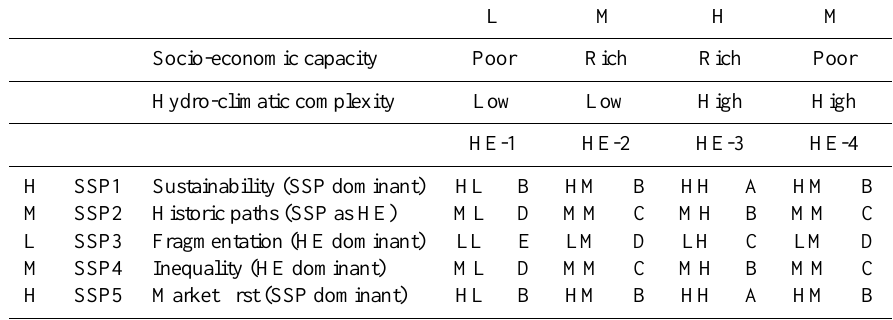
Table A3. The effect of technological changes on water use intensities in the industrial sector (H: high; M: middle; L: low). L M H M Socio-economic capacity Poor Rich Rich Poor Hydro-climatic complexity Low Low High High HE-1 HE-2 HE-3 HE-4 H SSP1 Sustainability (SSP dominant) HL B HM B HH A HM B M SSP2 Historic paths (SSP as HE) ML D MM C MH MM L SSP3 Fragmentation (HE dominant) LL E LM M SSP4 Inequality (HE dominant) SSP5 Market first (SSP